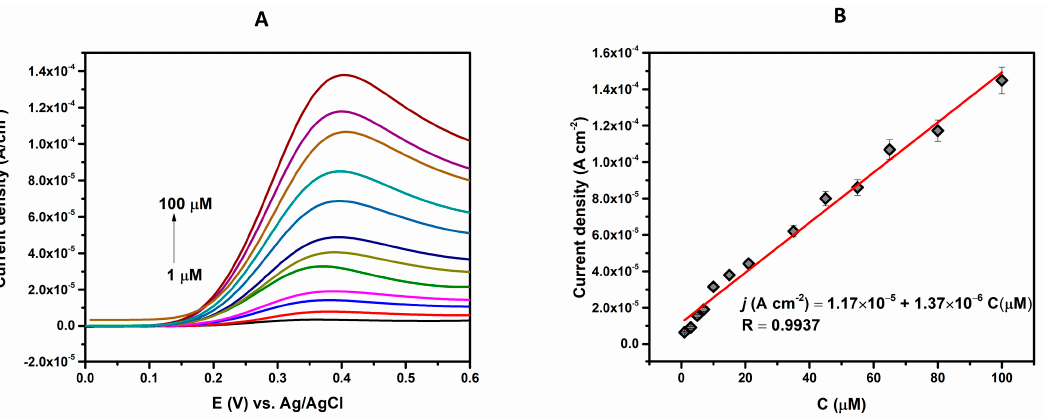
Figure 6. ( A ) DPV oxidation current response for the Eu 2 O 3 @Cr 2 O 3 /CPE towards various concentra- tions of L-DOPA (1–100 µ M) in BRBS (pH 7.0) ( B ) Calibration curve of current response depending on the concentration of L-DOPA in the analyte